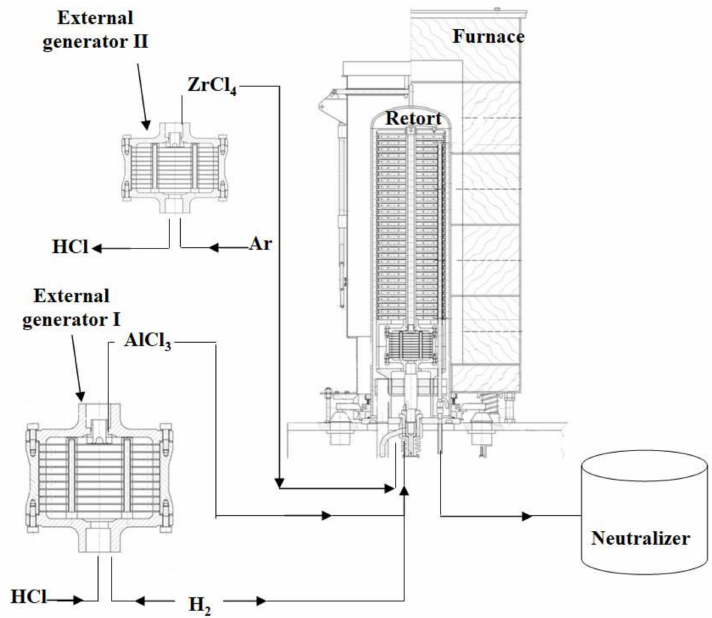
Figure 1. CVD equipment. Aluminium chloride vapor (AlCl 3 ) was produced in the external generator I (Figure 1) with aluminium pellets by running HCl gas. Zirconium chloride vapor (ZrCl 4 ) was pro- duced in external generator II (Figure 1) with zirconium pellets by running HCl gas. Both precursors (AlCl 3 and ZrCl 4 ) were transported to the retort, in which samples with Pd layer were placed, and heated to 1050 ◦ C. The AlCl 3 vapor reacted more with the ZrCl 4 vapour than with nickel at the temperature 1050 ◦ C and grains of intermetallic phase NiAl(Zr) were formed. The temperature profile of the process is presented in Figure 2.